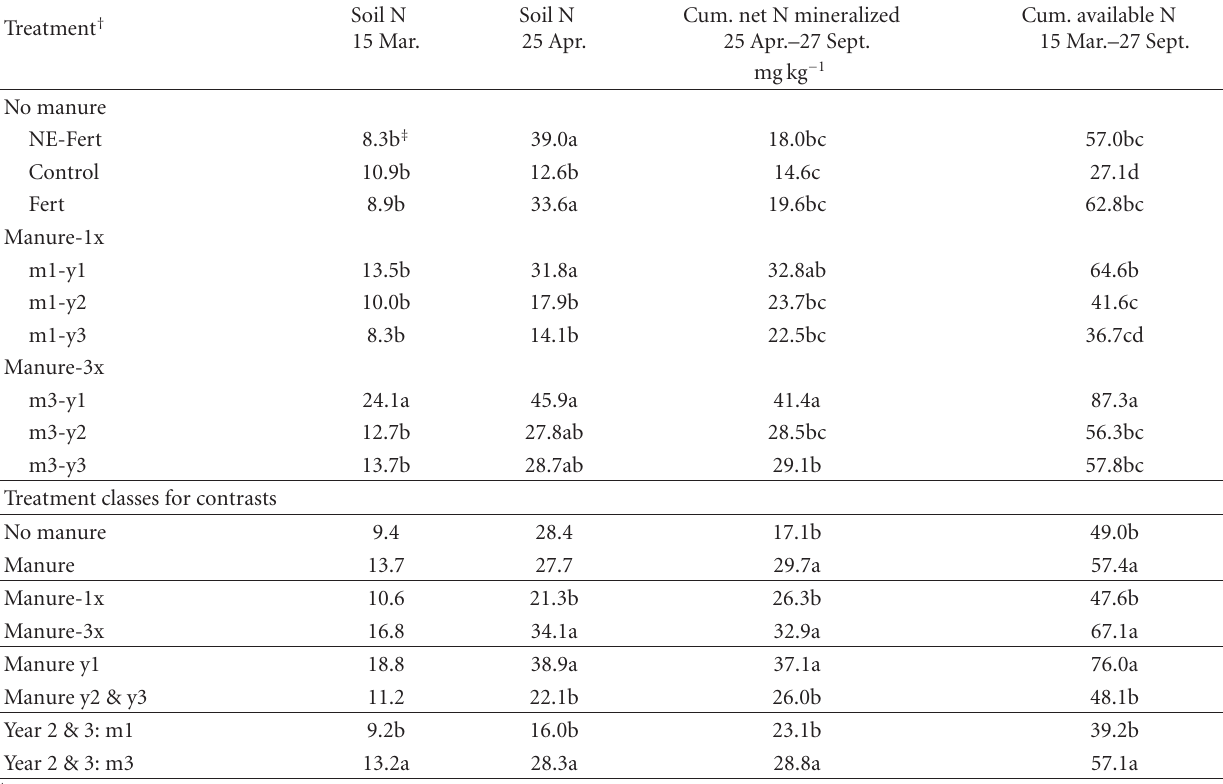
Table 6: Treatment and contrast class mean values for soil (0–30 cm) inorganic N concentrations in spring (before and after planting), cumulative net N mineralization, and cumulative available N during the growing